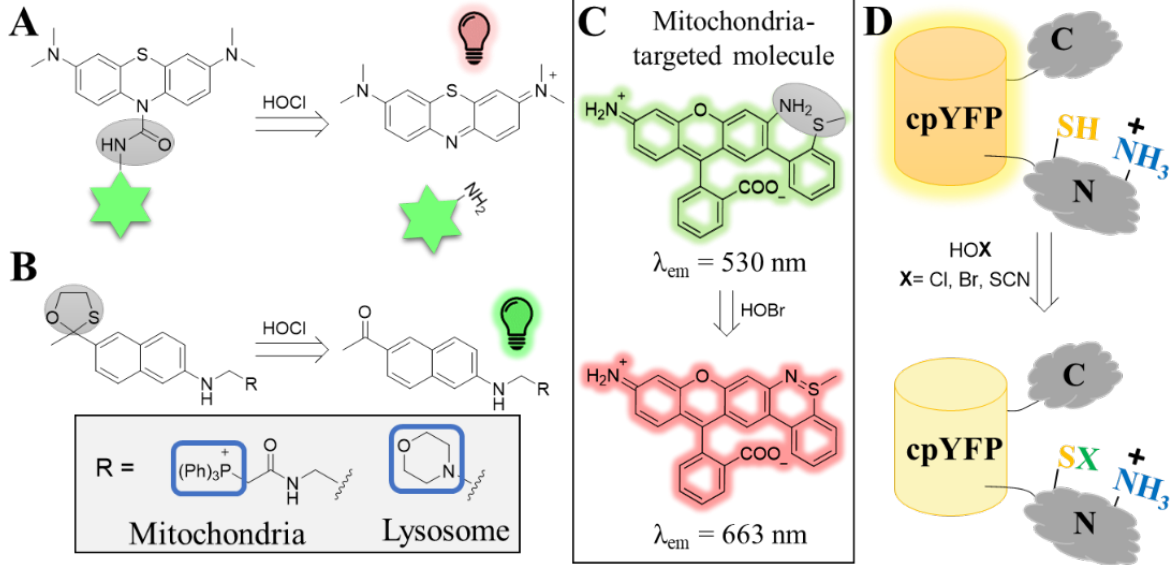
Figure 3. Tools for the visualization of hypohalous acids. ( A ) Structure and turn-on mechanism of the methylene blue-based probe (FDOCl-18) upon sensing HOCl. The methylene blue (top structure) is conjugated to naphthalene (indicated as a green star) through the HOCl-sensing group (highlighted by the gray oval, left structure). The methylene blue is non-fluorescent while the sensing group is attached. Upon sensing HOCl, a deformylation mechanism takes place that leads to the liberation of the methylene blue, which is now fluorescent. ( B ) Sensing mechanism of the organelle-specific turn-on probe for HOCl. The fluorescence properties of a two-photon dye (acedan) were quenched by HOCl-labile group (gray circle, left structure). The probe was further equipped with organelle specific-targeted moieties to drive it either to mitochondria (MITO-TP) or to lysosomes (LYSO-TP). ( C ) Structure of the HOBr ratiometric probe RhSN-mito. In the absence of HOBr, the probe emits at 530 nm. Reaction of the sensing moiety (gray oval, top structure) with HOBr leads to the formation of an additional ring that alters the fluorescence properties of the probe, which now emits at 663 nm. ( D ) The NemR-cpYFP construct (Hypocrates) for detecting hypohalous acids. The YFP was integrated onto a flexible loop of the NemR. While the YFP exhibits the high fluorescence in non-oxidation conditions, the intensity decreases when the thiol of the cysteine senses the hypo- halous acid.